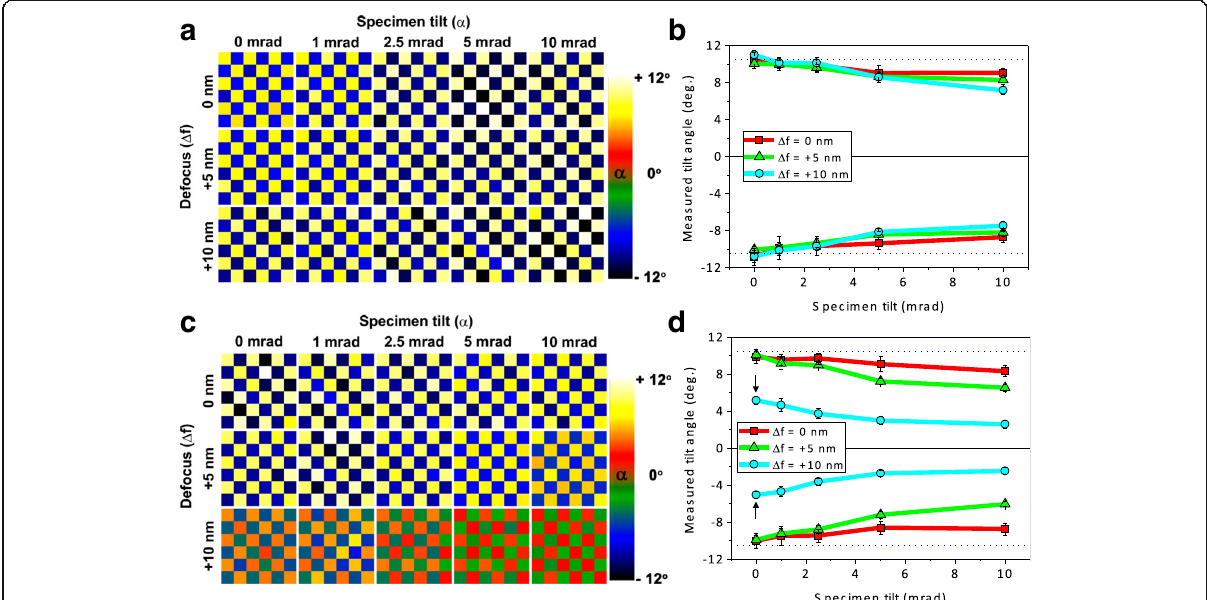
Fig. 3 Effect of specimen tilt in measuring oxygen octahedral tilts in BFO with 10.7 nm thickness. Oxygen octahedral tilt maps as a function of specimen tilt and defocus calculated from simulated a BF and c ABF images, respectively. b , d Line profiles of octahedral tilts averaged over vertical rows of the tilt maps shown in a and c , respectively. The dotted lines in the graphs indicate the tilt value (± 10.5°) of bulk BFO for the [110] pc projection. Simulations for 100 kV, spherical aberration coefficient − 0.037 mm, probe semiangle 31 mrad, and BF and ABF collection angles 0 – 1 and 8 – 20 mrad, respectively. Reproduced from Kim et al. 2017. Copyright 2017 with permission from